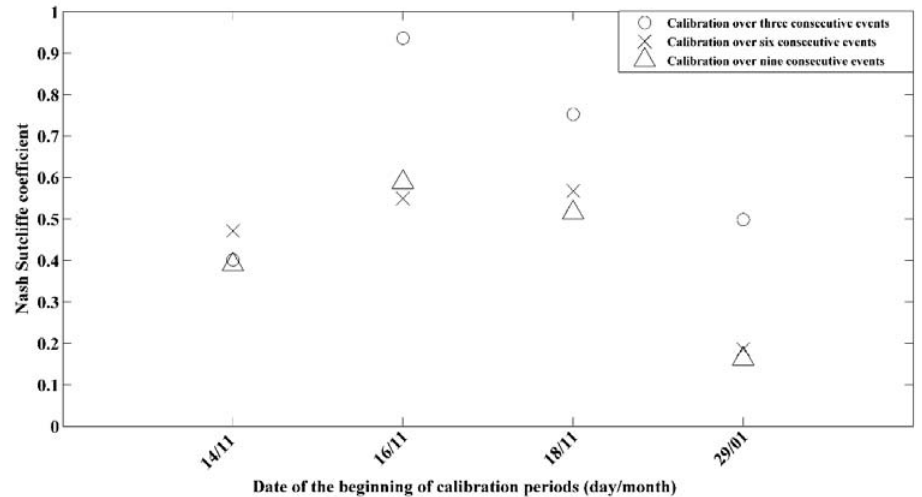
Figure 10. Nash coefficients calculated over four periods considering calibration over three, six and nine continuous.